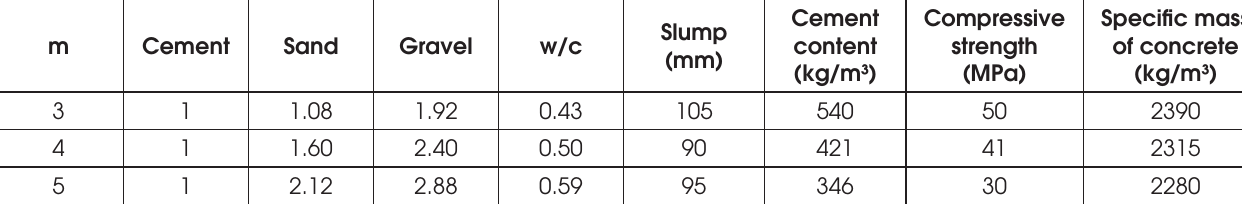
Summary of the proportions of materials in concretes